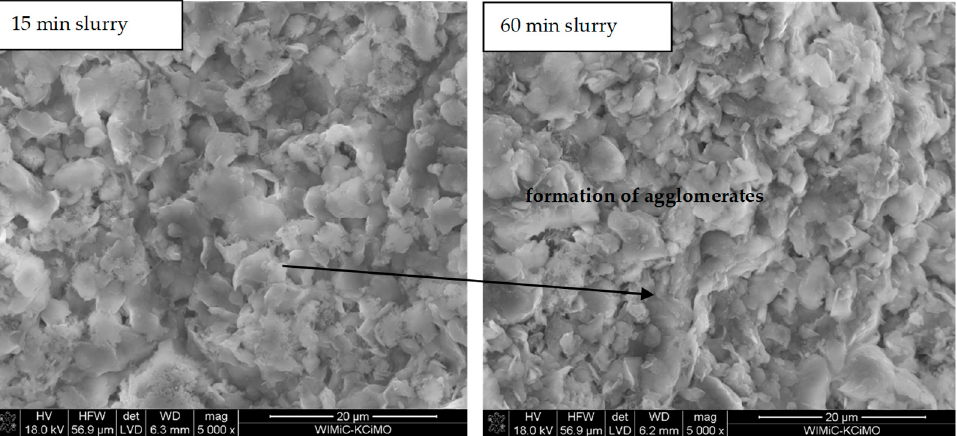
Figure 11. SEM microphotographs of clay–cement slurry prepared on a smectite clay base with 10% cement addition [46].